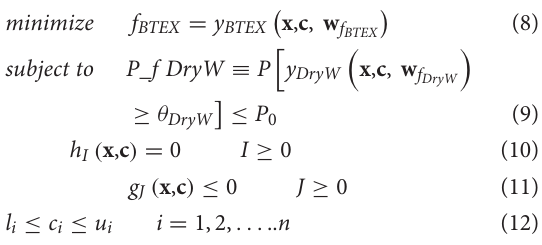
Figure 4 is the algorithmic flow diagram for